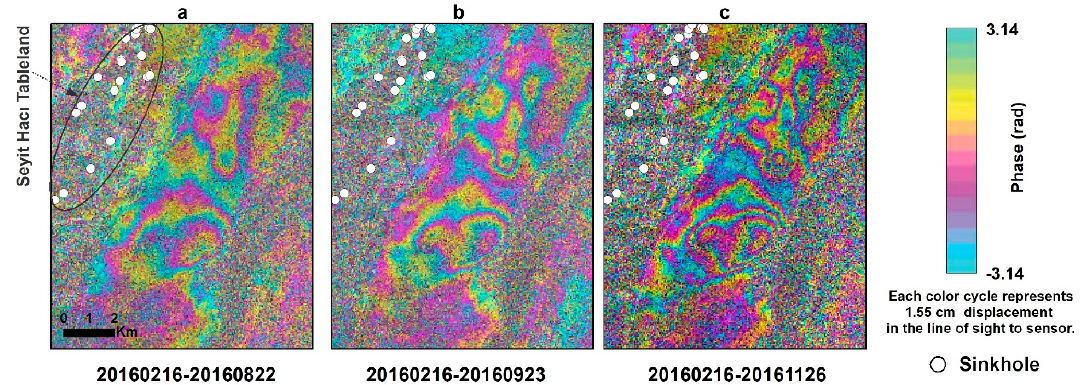
Figure 5. Land subsidence evolution of an area located north of the Karapinar (area A in Figure 4), as observed by COSMO SkyMed Interferograms. ( a ) Six-month interferogram showing 1–2 fringes of subsidence. ( b ) Seven-month interferogram showing 2–3 subsidence fringes. ( c ) Nine-month interferogram showing 3–4 subsidence fringes, mostly in the southern part of the subsiding area.